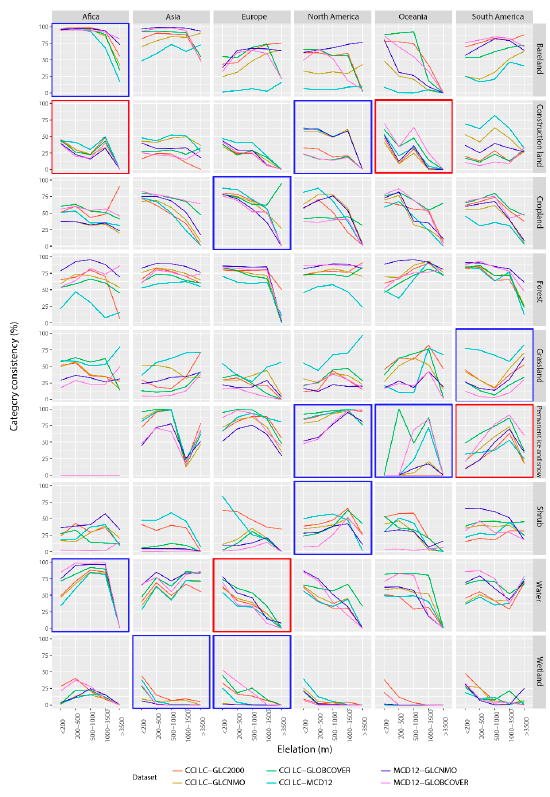
Figure 4. Category consistency of continental elevations. The red outlines show that the gradient characteristics of the six datasets are similar, while the blue outlines show that the gradient characteristics of only five datasets are